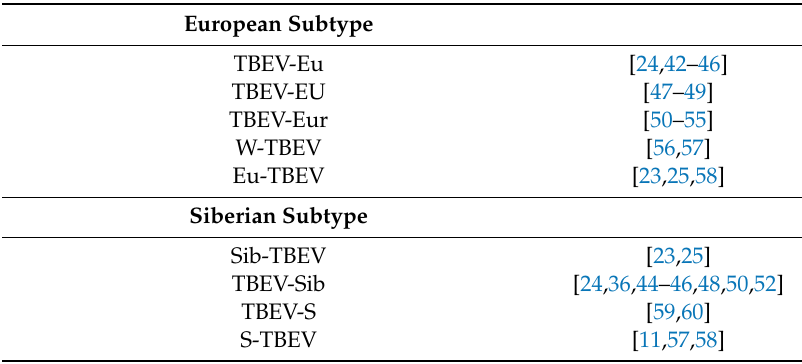
Table 2. Variants of TBEV subtype